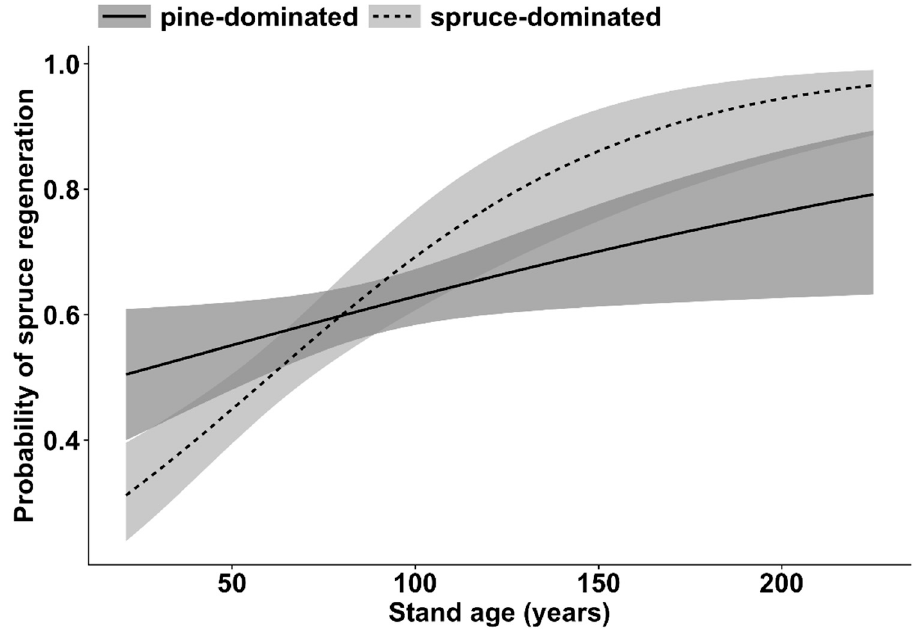
Figure 5. The influence of stand age on the probability of advance regeneration of Norway spruce in Scots pine and Norway spruce-dominated stands. The grey area represents a ±95% confidence interval.